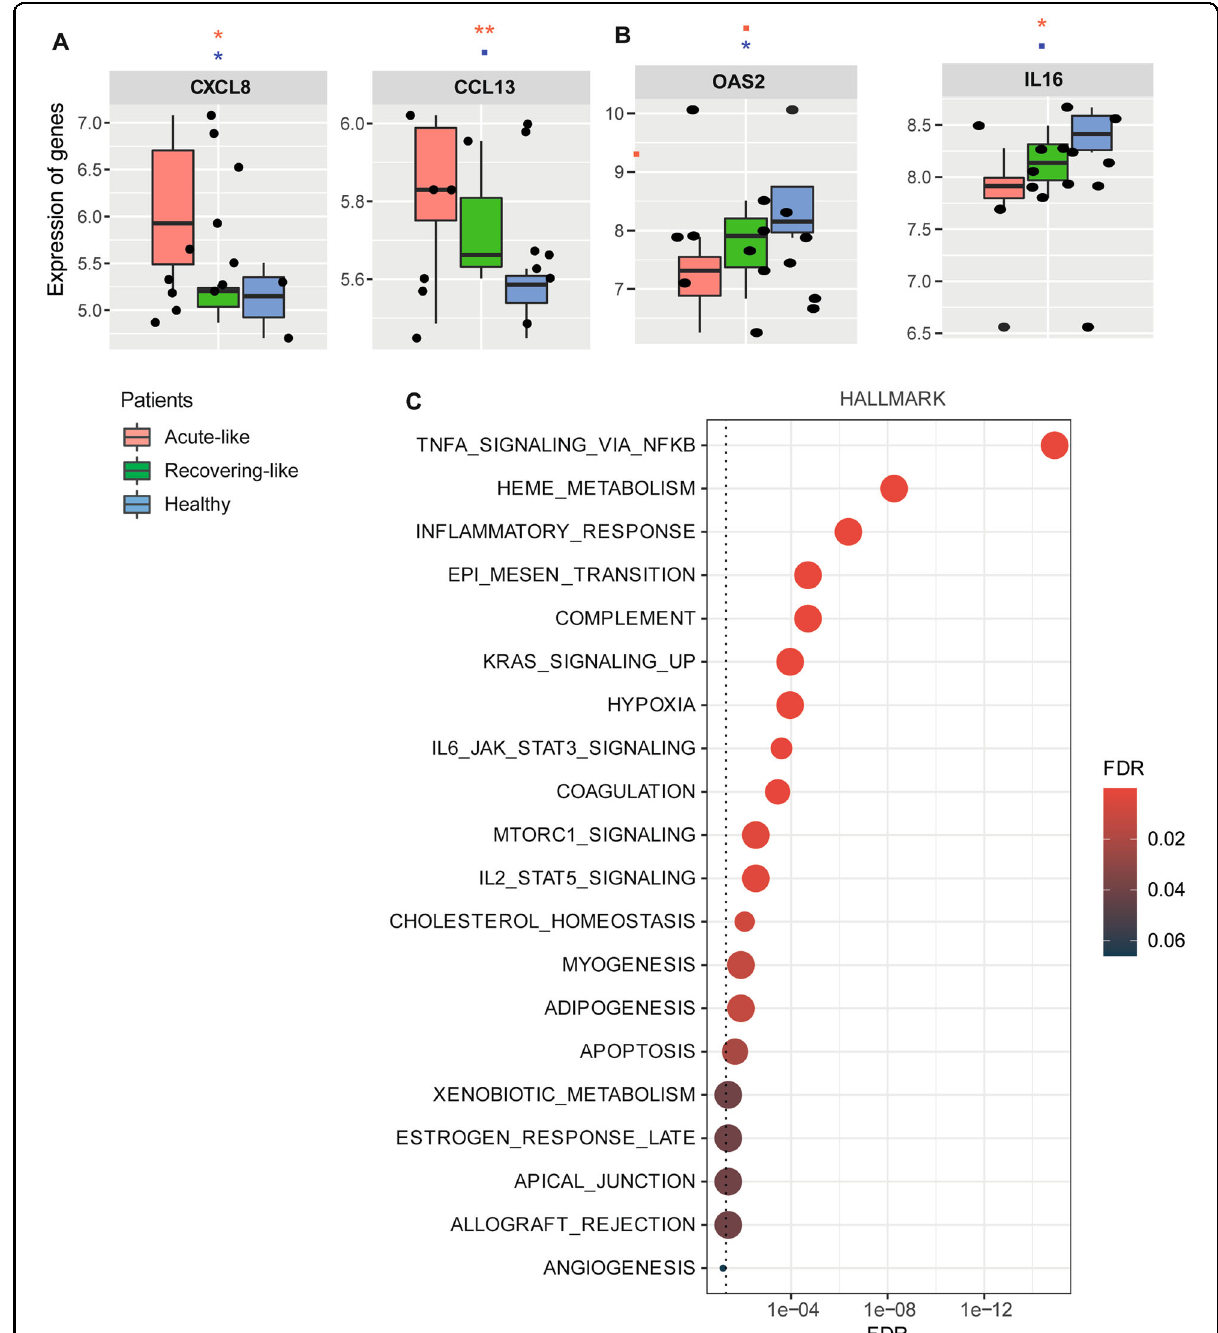
Fig. 3 Highly represented signaling pathways/processes in coronavirus-infected patients. A , B Expression levels of genes related to immune cell chemoattractants CXCL8 and CCL13 ( A ), genes involved in T cells and suppression of viral replication OAS2 and IL16 ( B ) in acute-like and recovering-like coronavirus-infected patients and healthy individuals. Blue asterisk (*) represents Kruskal – Wallis nominal p value across all three groups and red asterisk (*) represent Welch two-sample t- test p value between patients and healthy individuals. * p < 0.05; ** p < 0.001; *** p < 0.0001 and ■ p < 0.08. Multiple testing was not done due to low sample size. C Enrichment statistical analysis (hypergeometric test using hypeR 57 ) using CoV-Up-gene signature and pathways/processes based on gene sets from MSigDB ’ s HALLMARKS database 20